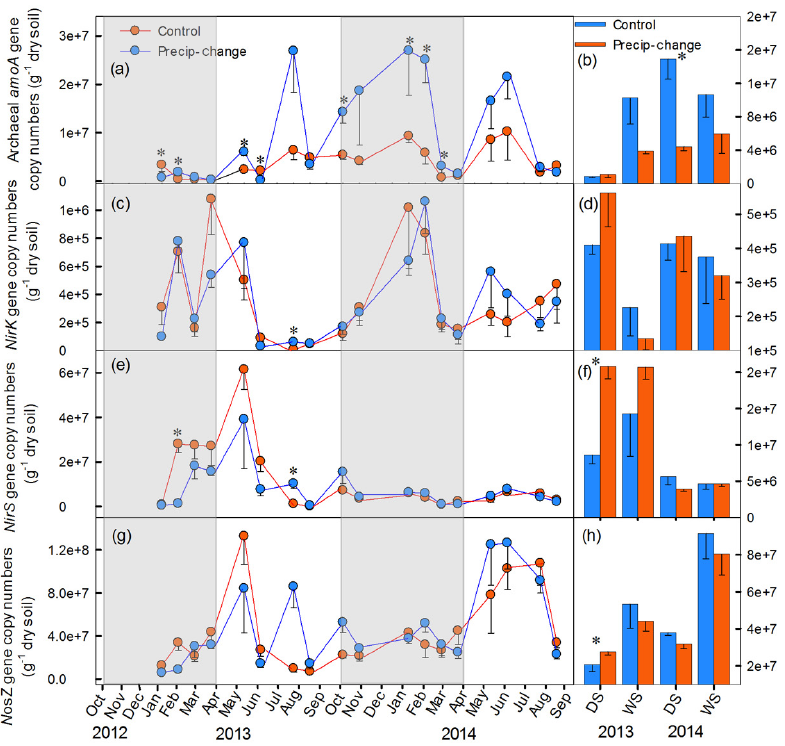
Figure 4. Copy numbers of archaeal amoA , nirK , nirS and nosZ gene per gram of dry soil measured in control and precipitation change (precip-change) plots over the course of experiment. Points and bars with standard error ( n = 4) show mean values at each sampling time and in dry (DS) and wet (WS) seasons. Grey shades indicate the periods of precipitation reduction. The significance levels are presented as ∗ p < 0 .